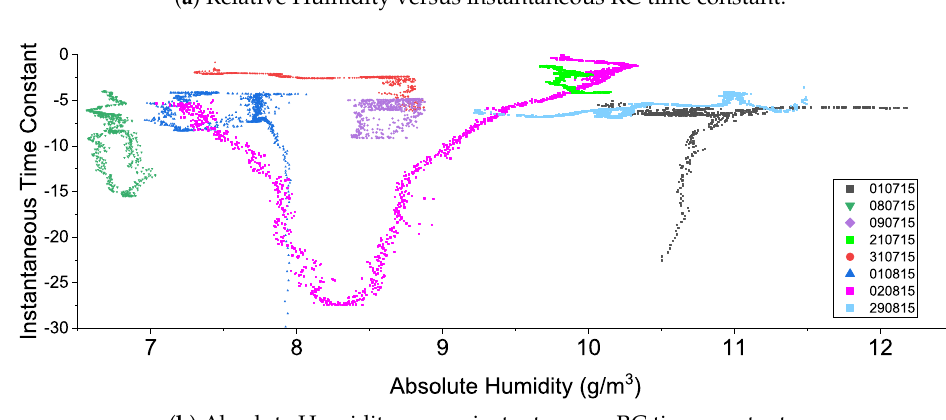
Figure 11. Scatter plots showing AH and RH against the instantaneous RC time constant. The data are colour coded by the date of the